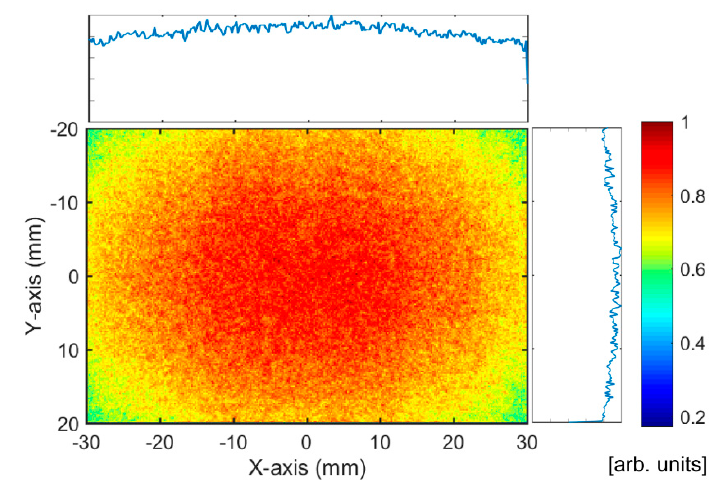
Figure 6. Calculated result of pump distribution.